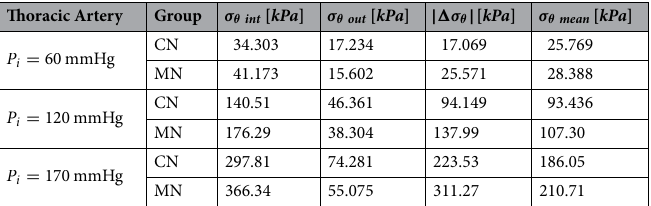
Table 3. Circumferential stress from the simulation of the presurization on the thoracic aorta for pressures P i = 60, 120 and 170 mmHg. The simulation added fisiological axial stretch (cid:31) z = 1.20 .